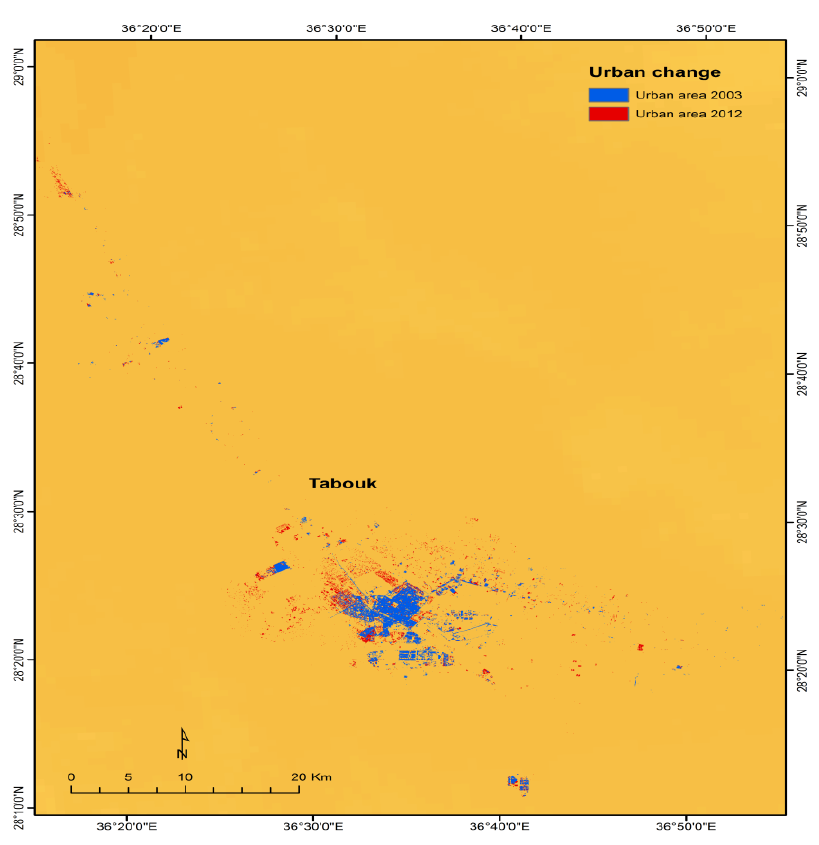
Figure 6. Urban expansion in Tabouk.